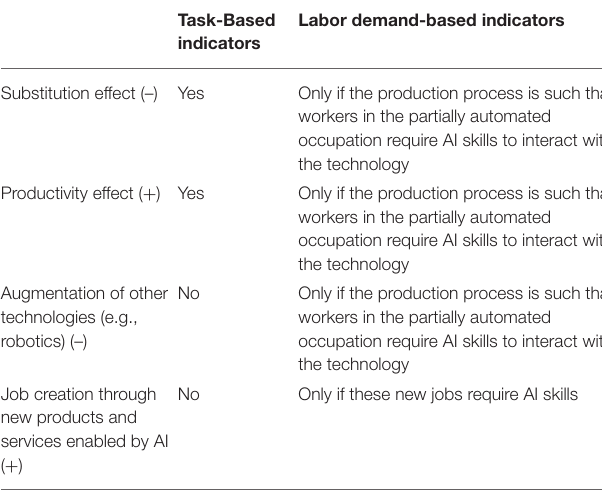
TABLE 1 | Which potential employment effects of AI can task-based and labor-demand based indicators capture? Task-Based